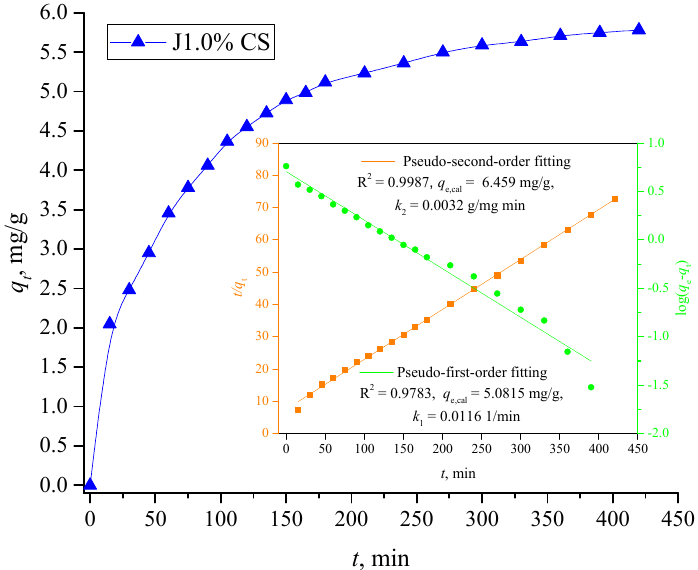
Figure 11. Adsorption of RO 16 onto J1.0% CS as a function of contact time, inset: Pseudo-first and pseudo-second-order kinetic models and calculated kinetic parameters ( c 0 = 25 mg/L, t = 0–7 h, T = 25 °C, pH of 2.0 (for J, J0.5% CS, and J1.0% CS) and 4.0 (for J2.0% CS), the mass of adsorbent 0.25 g).